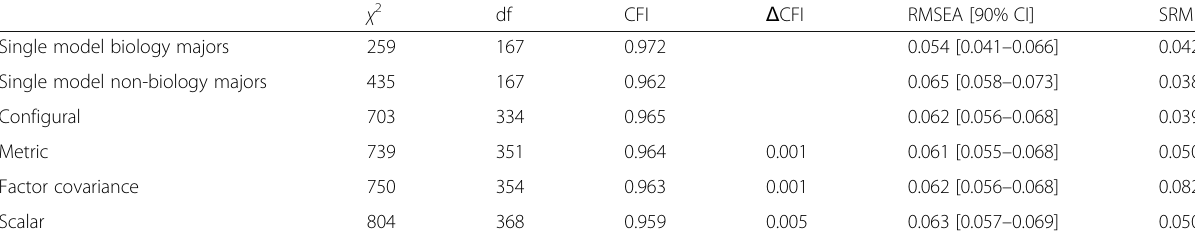
Table 5 Test of measurement invariance of the interest instrument across biology majors ( n = 222) and non-biology majors ( n = 489)